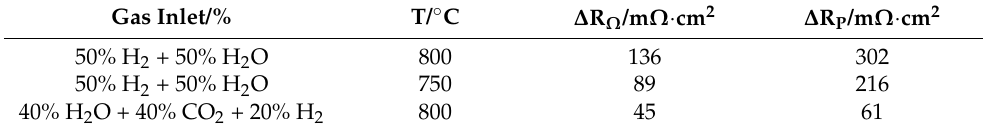
Table 2. Changes in ohmic and polarization resistance at the beginning and the end of durability testing.